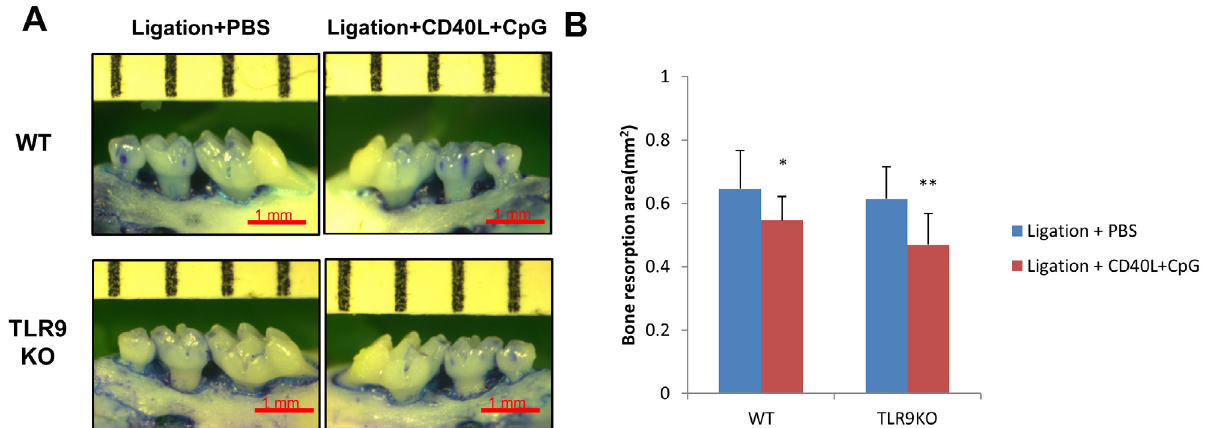
Figure 5- CpG+CD40L reduced bone loss in ligature-induced experimental periodontitis of WT and TLR9 KO mice. Silk ligatures were tied around the maxillary secondary molars on day 0 and injection of CpG (1 μM)+CD40L (0.1 μg/ml) or PBS was performed in palatal gingiva on days 3, 6 and 9 in WT mice and TLR9 KO mice. Maxillae were collected on day 14, and the area of palatal alveolar bone loss around the maxillary secondary molars was pictured (A) and analyzed (B). Data were presented as the bone loss area (square millimeter) determined at a magnification of 30X (means±SD, n=4 WT or TLR9 KO mice per group, *p<0.05, **p<0.01, compared with PBS injection